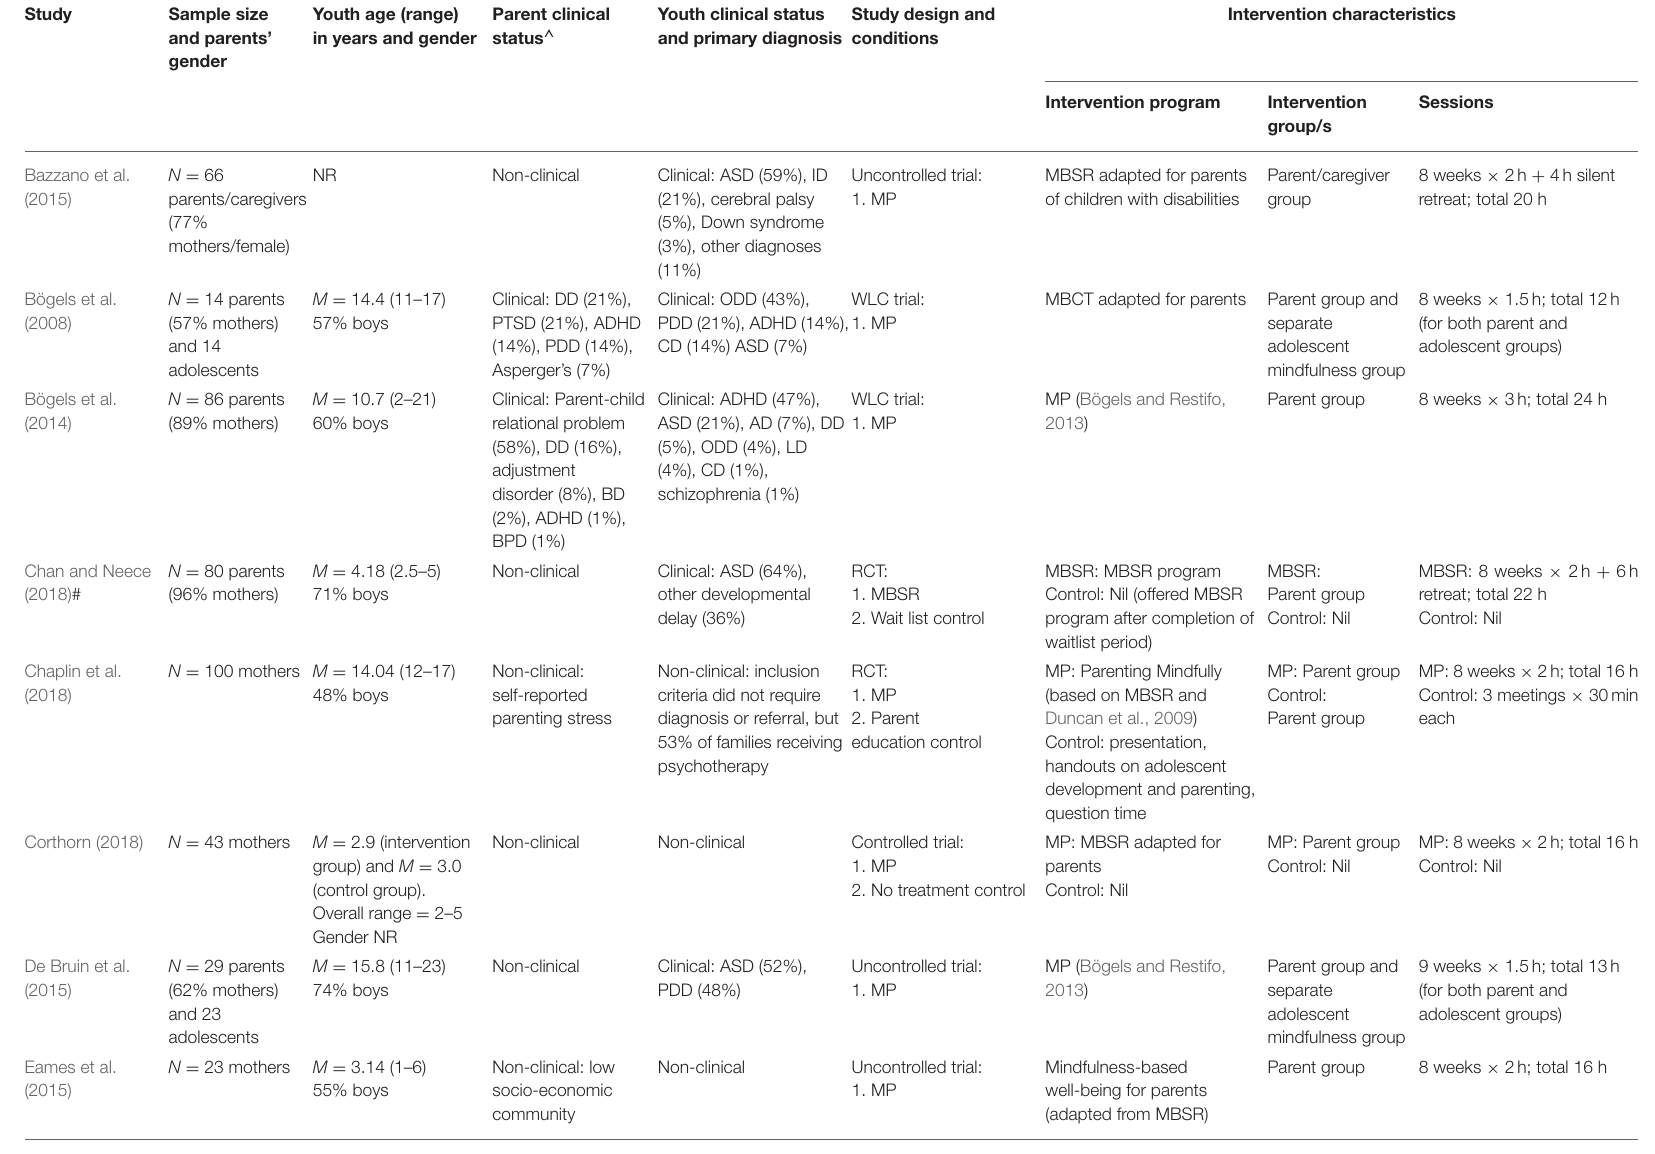
TABLE 1 | Details of included